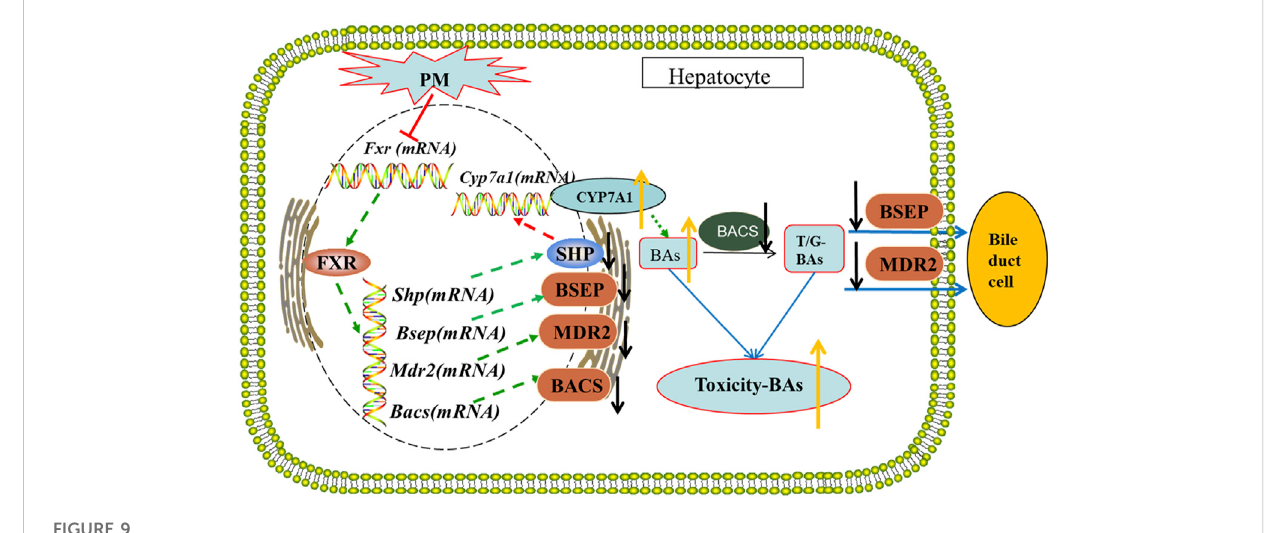
FIGURE 9 The possible mechanism of cholestatic liver injury by